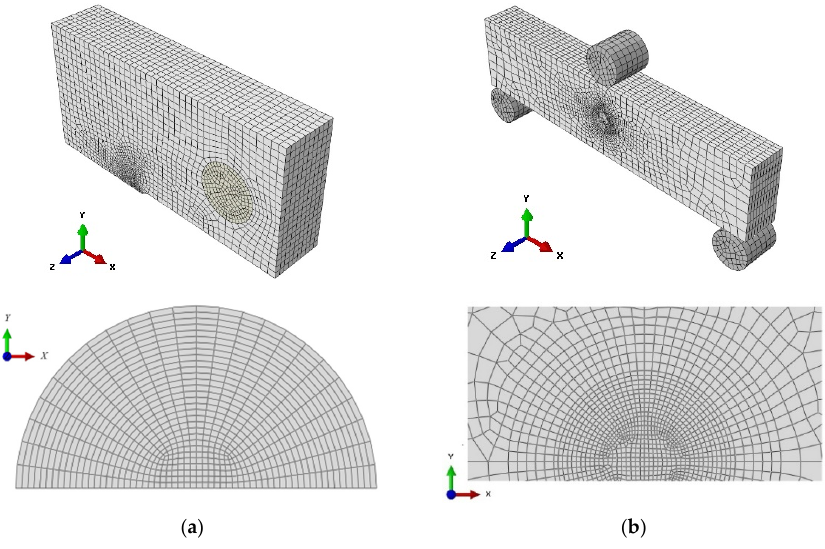
Figure 2. Mesh of global model and mesh around crack front: ( a ) C(T)50 specimen and ( b ) SE(B)10×10d